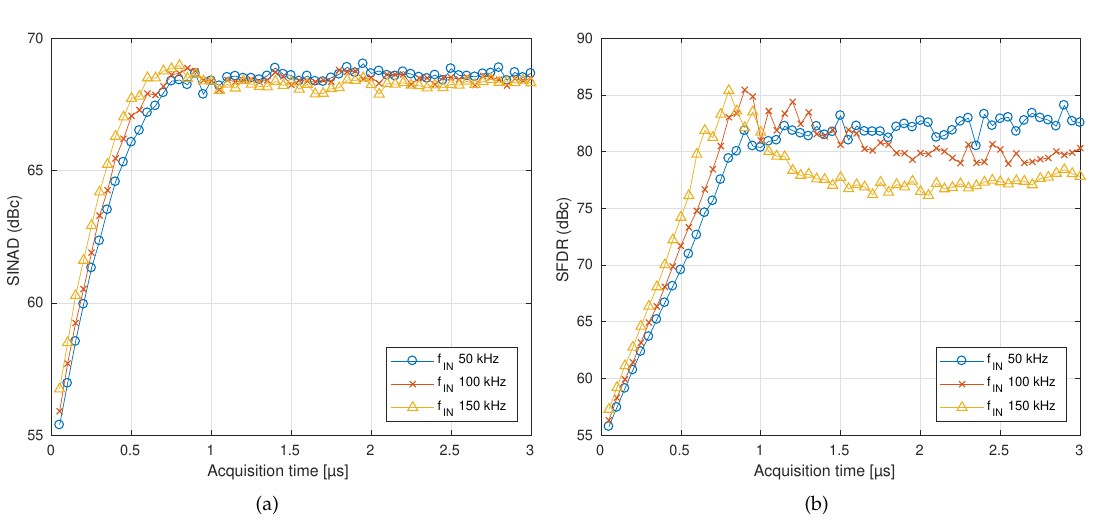
Figure 14. Spectral quality parameters of the ADC for different input frequencies and acquisition times. ( a ) signal-to-noise and distortion ratio (SINAD), ( b ) spurious-free dynamic range